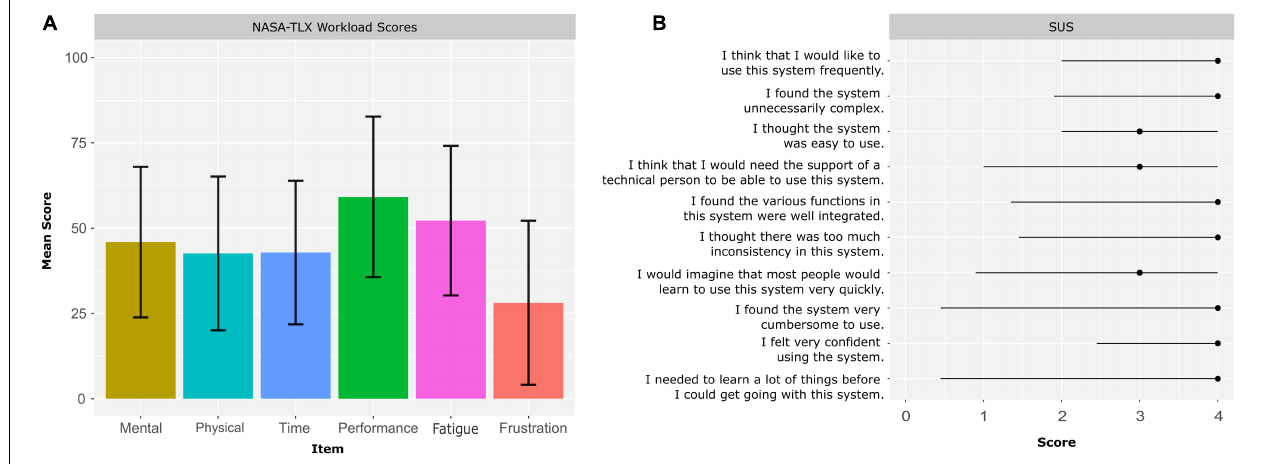
FIGURE 2 | Feasibility outcomes. (A) Mean ratings ± standard deviation of each item of the NASA-TLX to assess training workload, (B) median and interquartile range of the ratings of each SUS item.